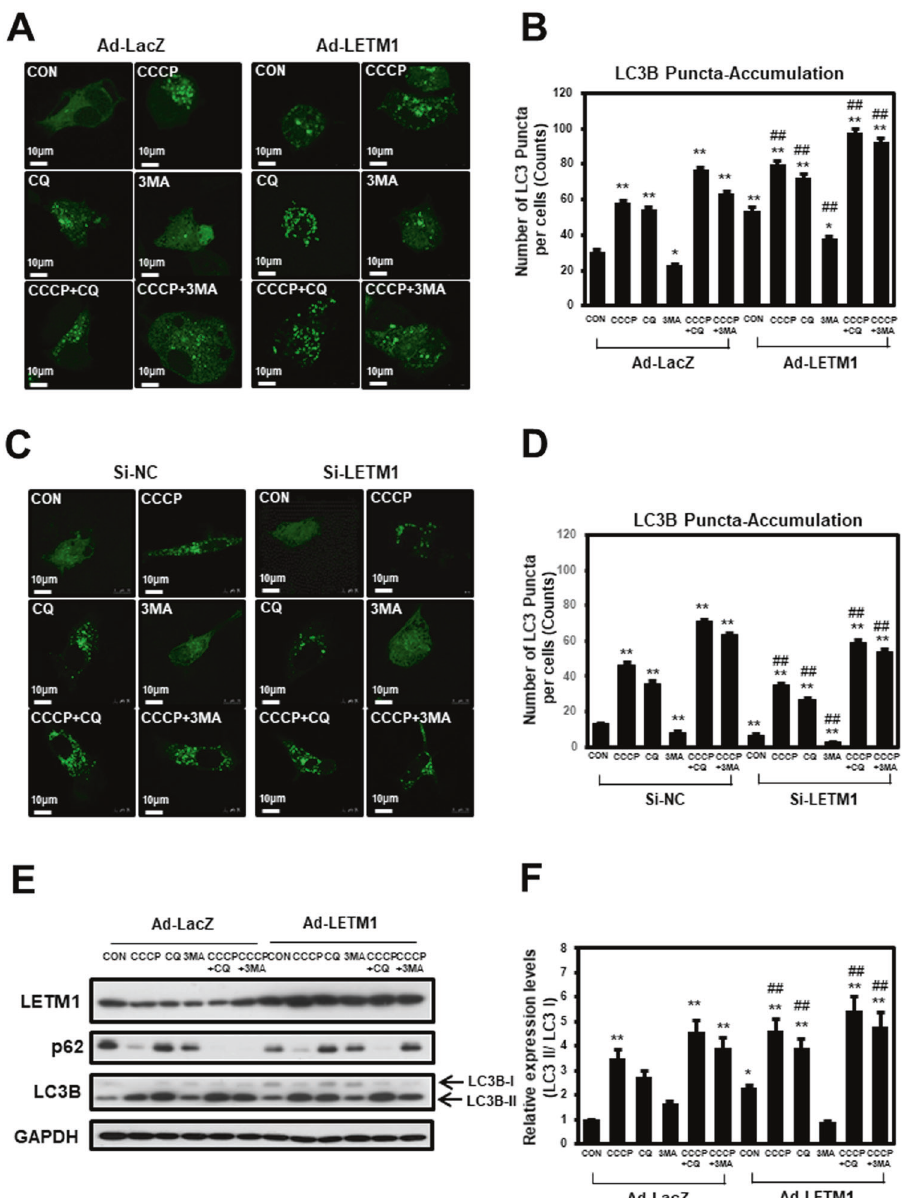
Fig. 1 The effects of Leucine zipper-, EF-hand-containing transmembrane protein-1 (LETM1) on autophagy in H460. A H460 cells were transfected with GFP-LC3, followed by infection with adenovirus-LacZ (Ad-LacZ) or adenovirus-LETM1 (Ad-LETM1) for 24 h. The cells were then treated with 30 μ M carbonyl cyanide m-chlorophenylhydrazone (CCCP), 10 μ M chloroquine (CQ), and 10 μ M 3-methlyladenine (3MA) for 8 h. The cells were further analyzed with confocal microscopy. The results are representative of three independent experiments. Scale bars represent 10 μ m. B GFP-LC3 puncta in H460 cells were counted in each condition ( n = 40). Data are expressed as the mean ± SD using one-way ANOVA with Tukey ’ s correction for multiple comparisons. * p < 0.05; ** p < 0.01, versus the control Ad-LacZ samples, # p < 0.05, control Ad-LETM1 versus Ad-LacZ samples. C H460 cells were co-transfected with si-RNA negative control of si-RNA LETM1 and GFP-LC3 for 24 h. The si-RNA LETM1 mediated cells were then treated with the indicated compounds. These images are representative of three independent experiments. Scale bars represent 10 μ m. D GFP-LC3 puncta in H460 cells were counted in each condition ( n = 40). Data are expressed as the mean ± SD using one-way ANOVA with Tukey ’ s correction for multiple comparisons. * p < 0.05; ** p < 0.01, versus the control si-NC samples, # p < 0.05; ## p < 0.01, control si-LETM1 versus si-NC samples. E H460 cells were infected with Ad-LacZ or Ad-LETM1 for 24 h followed by CCCP, CQ and 3MA treatment for 8 h. The total cell lysates were immunoblotted for LETM1, p62, LC3B, and GAPDH. The results are representative of three independent experiments. F Relative densities of each protein were obtained by analyzing the blot using ImageJ software (NIH, Bethesda, MD, USA). The relative expression of LC3B II protein was calculated by normalizing all density values to that of LC3B I in each lane. The results are displayed as mean ± SD and are representative of three independent experiments. * p < 0.05; ** p <